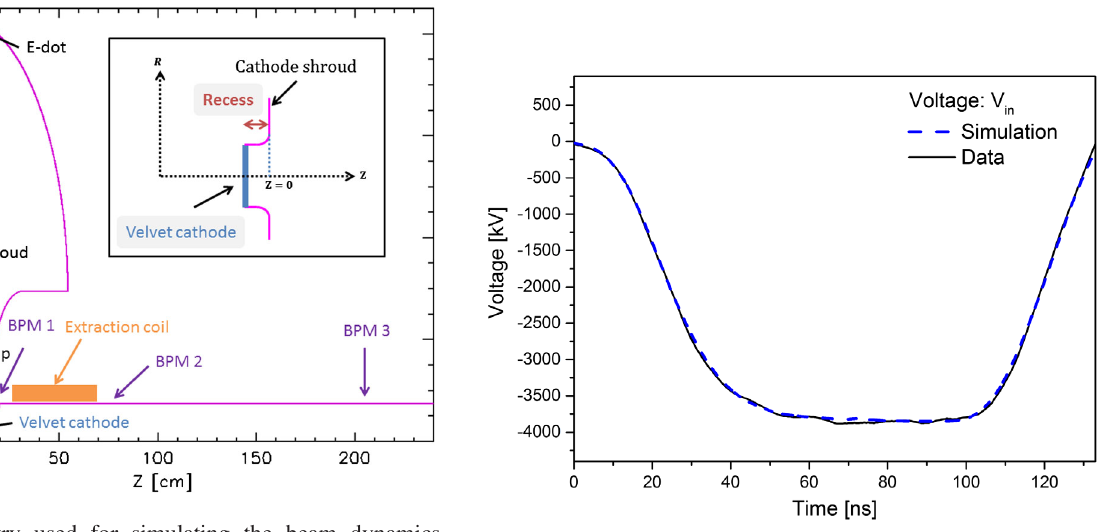
FIG. 2. Typical measured voltage on EPURE axis-1 (black) and simulated voltage (dashed blue) used as an inlet boundary in the simulation ( V in Fig. in